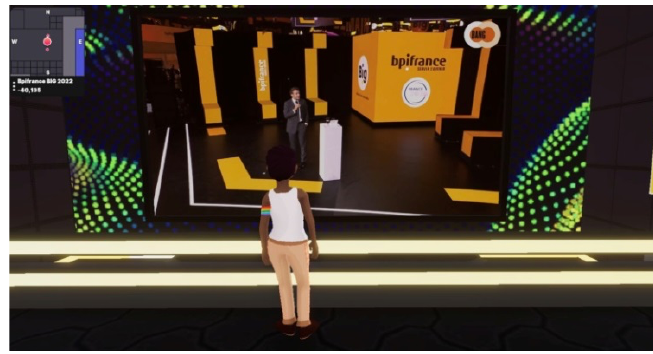
Figure 14: President of France in the